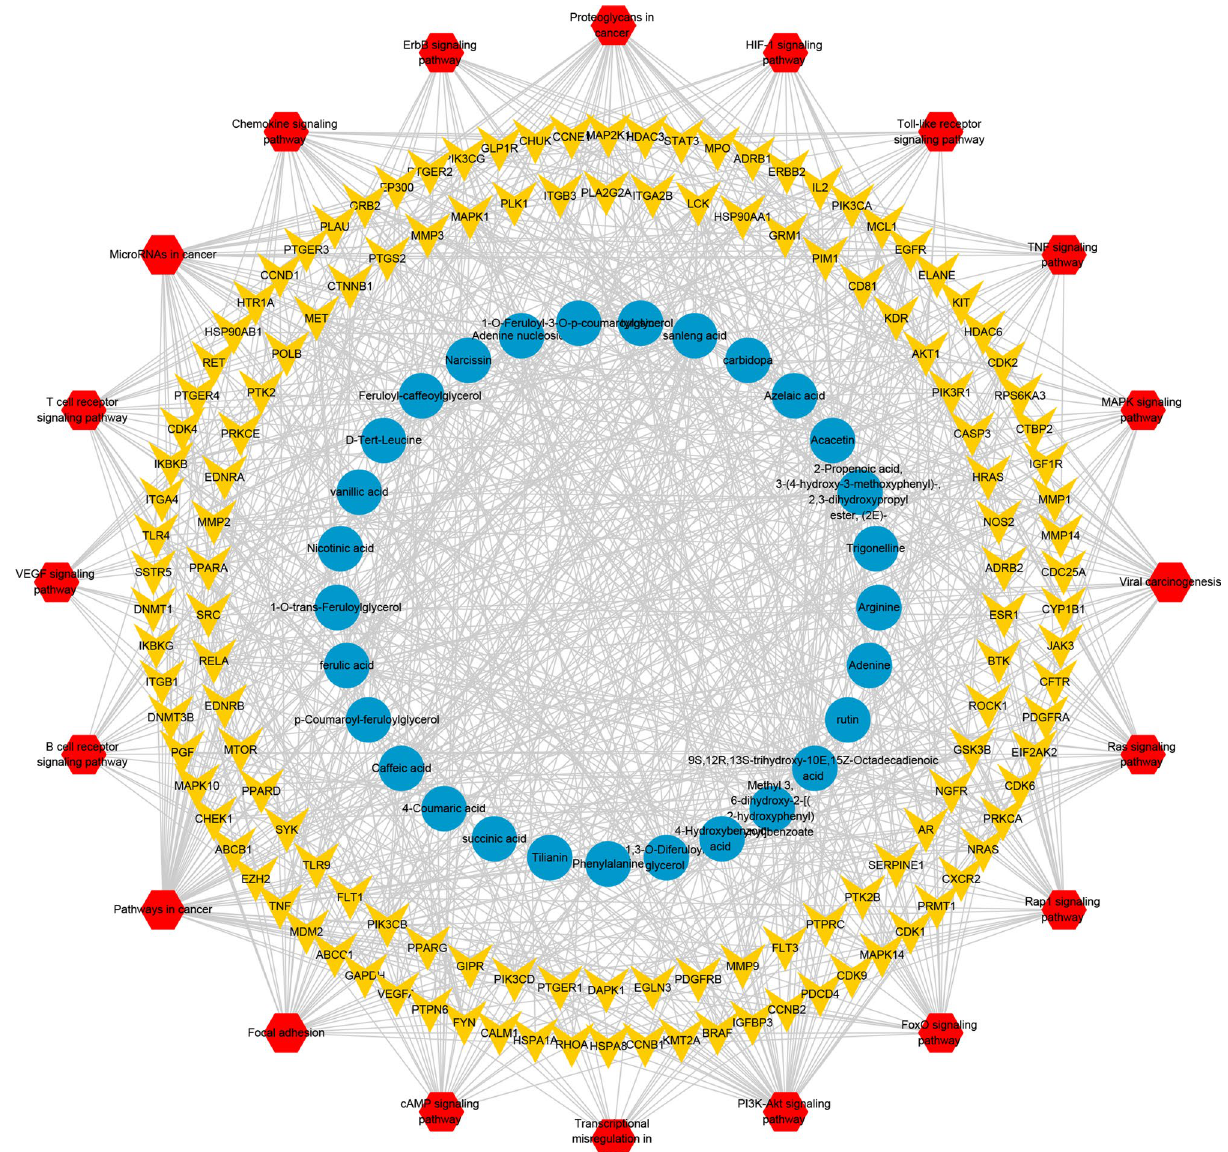
Figure 6. Compound-target-pathway network. Blue circular nodes represent chemical compounds, yellow V-shaped nodes represent targets, and red hexagonal nodes represent